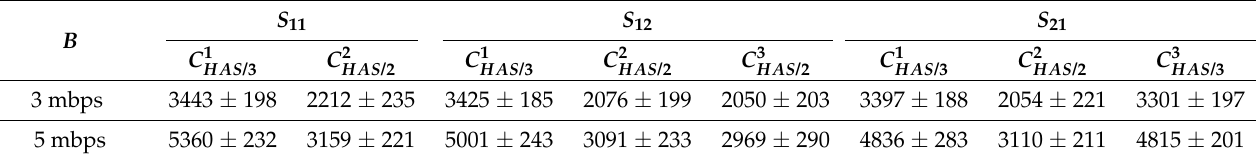
Table 7. The average number of cwnd updates of each client running the fairness